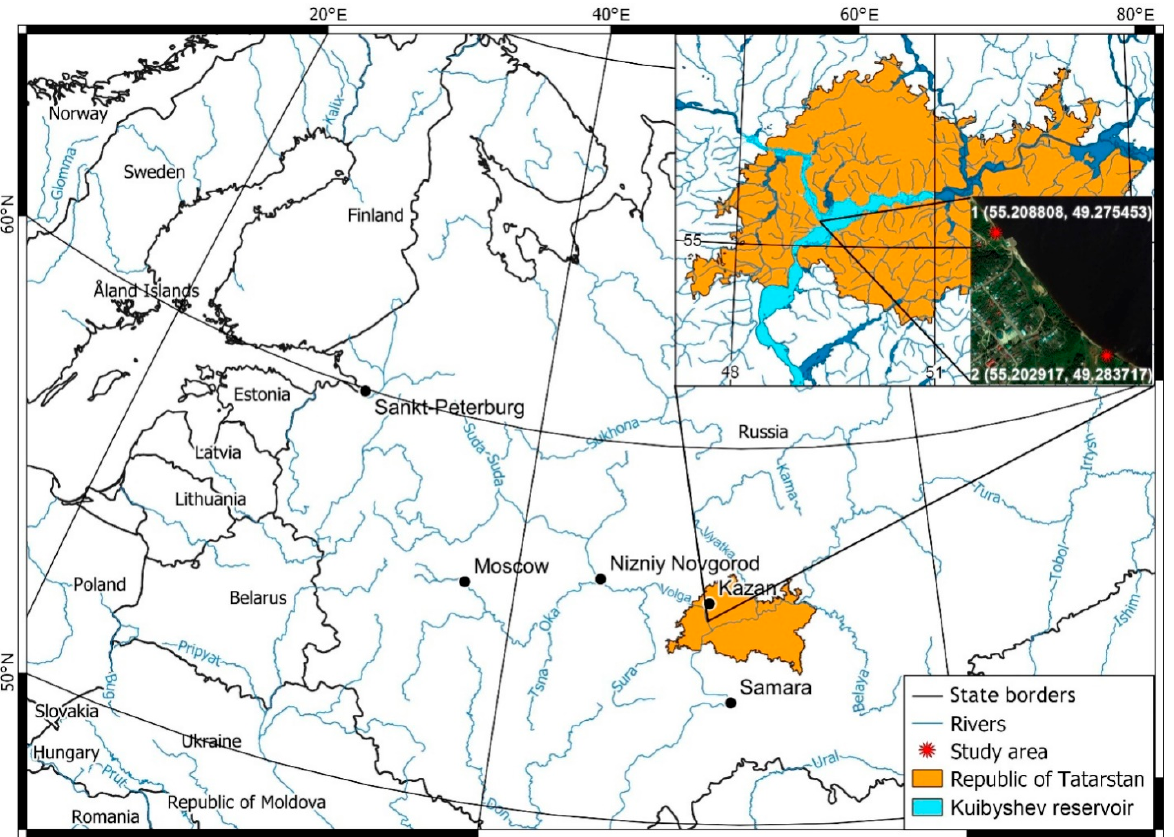
Figure 1. Location of the Kuibyshev reservoir on the Volga River and the two study sites in the East of the Russian Plain.